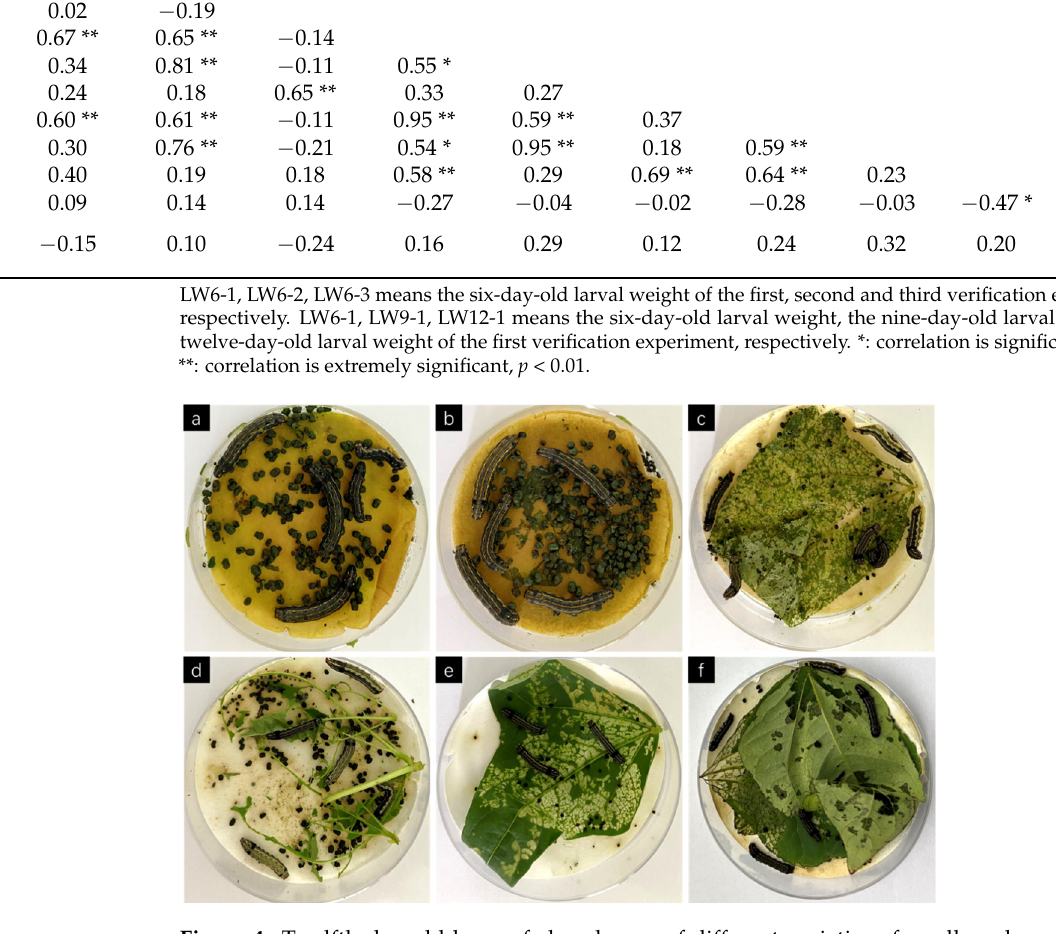
Figure 4. Twelfth-day-old larvae fed on leaves of different varieties of yardlong bean. Sensitive variety: ( a ) Zhuzaidou; ( b ) Pingtangjiangdou. Resistant variety: ( c ) Jiangdou No.5; ( d ) j-1; ( e ) Zhijiangtezao No.30; ( f ) Changcaidou. Table 5. The larval weight and leaf nutrient content of the preliminarily screened insect-resistant and insect-sensitive varieties in verification experiments.